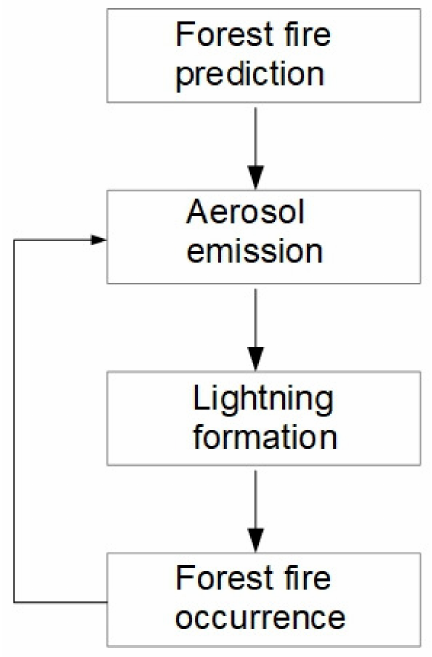
Figure 2. Scheme with feedback.